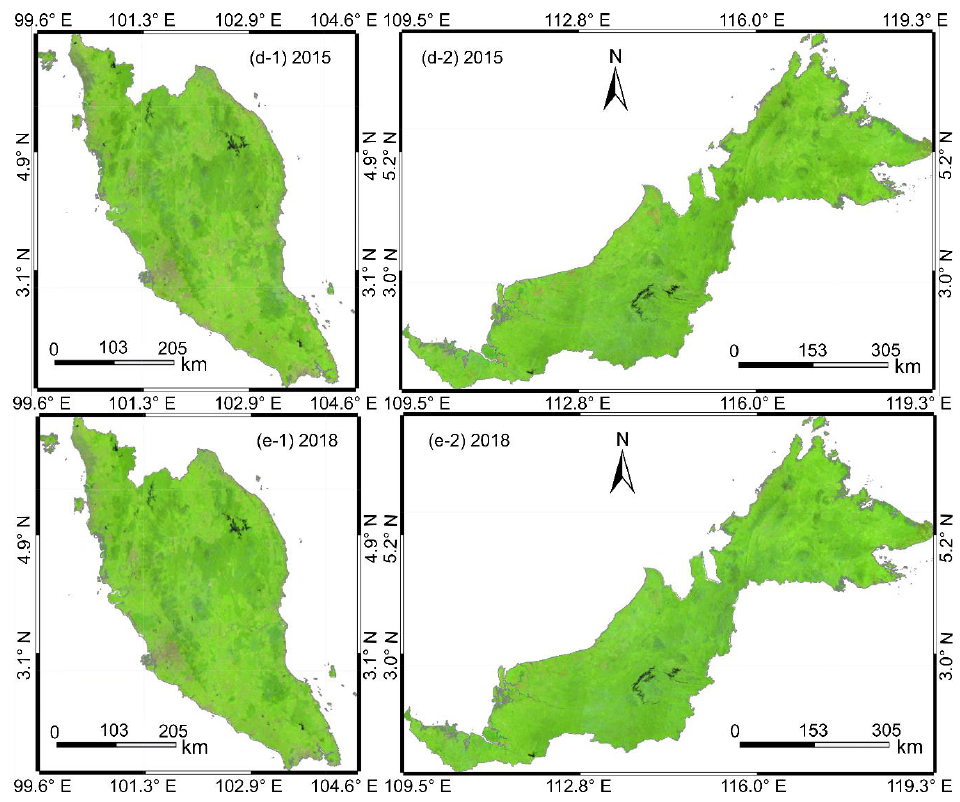
Figure 2. Short-wave infrared (SWIR)-NIR-red composite of annual Landsat synthetic image for